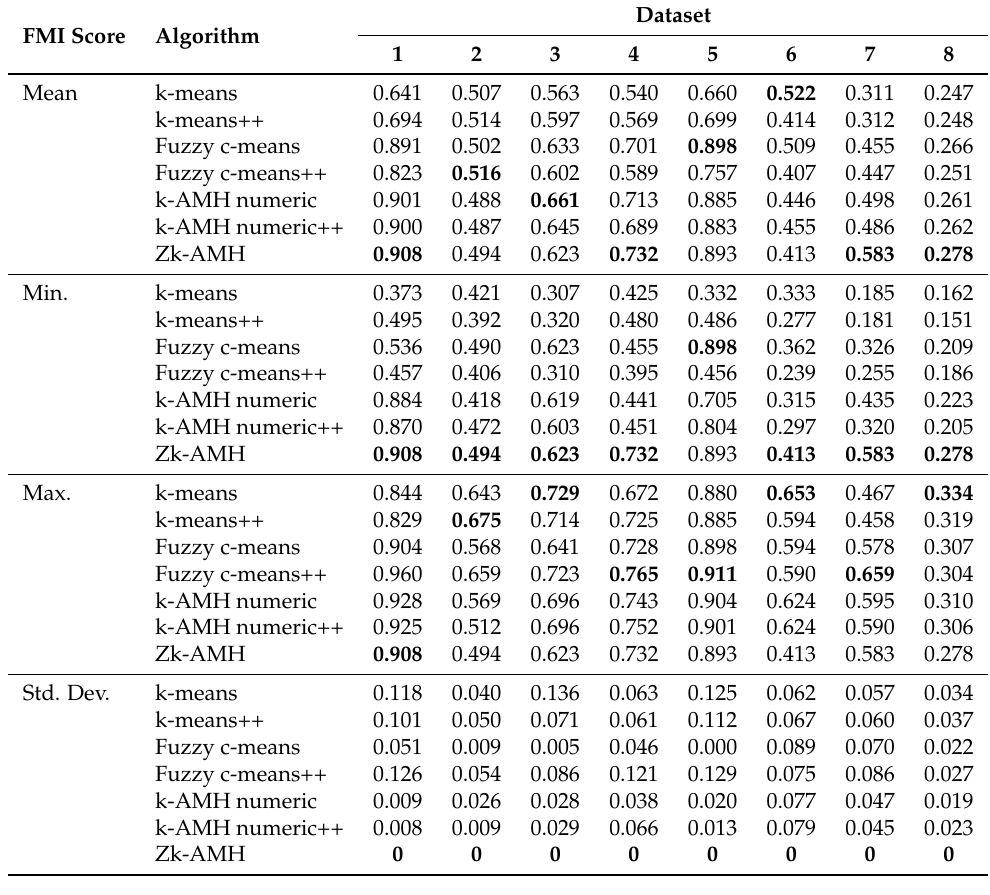
Table 4. Mean, Maximum, Minimum, and Standard Deviation for Each Algorithm and